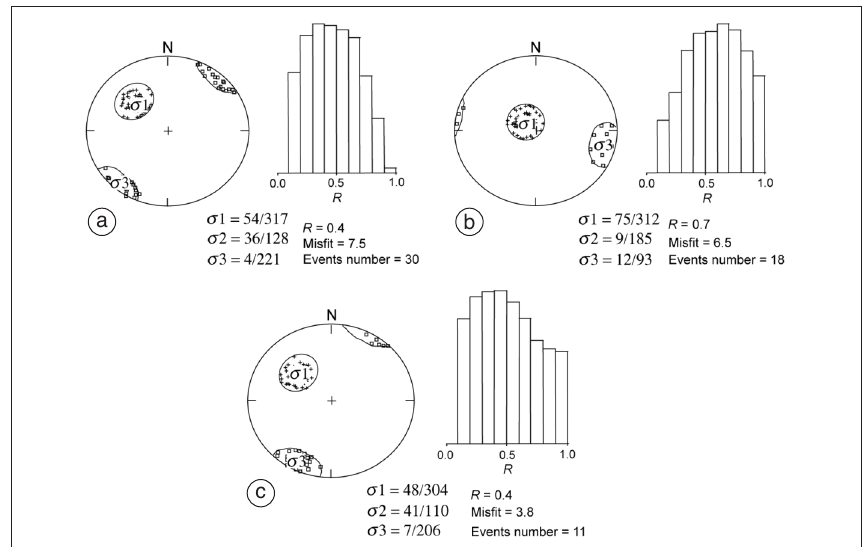
Fig. 8a-c. Stress inversion results using: a) 30 solutions; b) 18 solutions within the northern sector (Irpinia-Po- tentino-Savoia di Lucania-Calvello); c) 11 solutions of earthquakes within the southern sector (Moliterno-S. Mar- tino d’Agri). For the location of the two sectors see fig. 7. For each inversion is shown the stereonet plot with the 95% confidence limits for σ 1 (small crosses) and σ3 (small squares) and the histogram illustrating the uncertain- ity in the parameter R . Plunge and trend for the three principal stress axes are shown below the